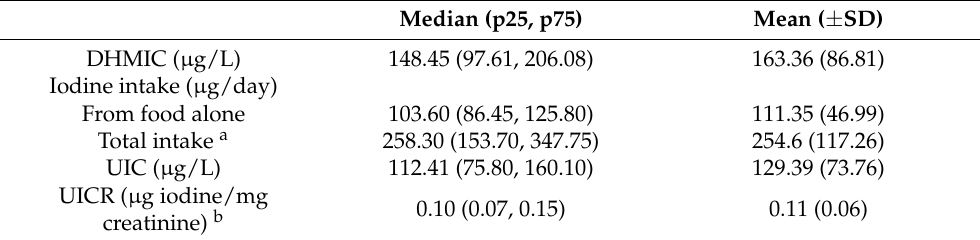
Table 2. Donor human milk iodine concentrations (DHMIC) of study participants (n = 113) along with iodine intake variables, urine iodine concentration (UIC) and urine iodine creatinine ratio (UICR). Median (p25, p75)